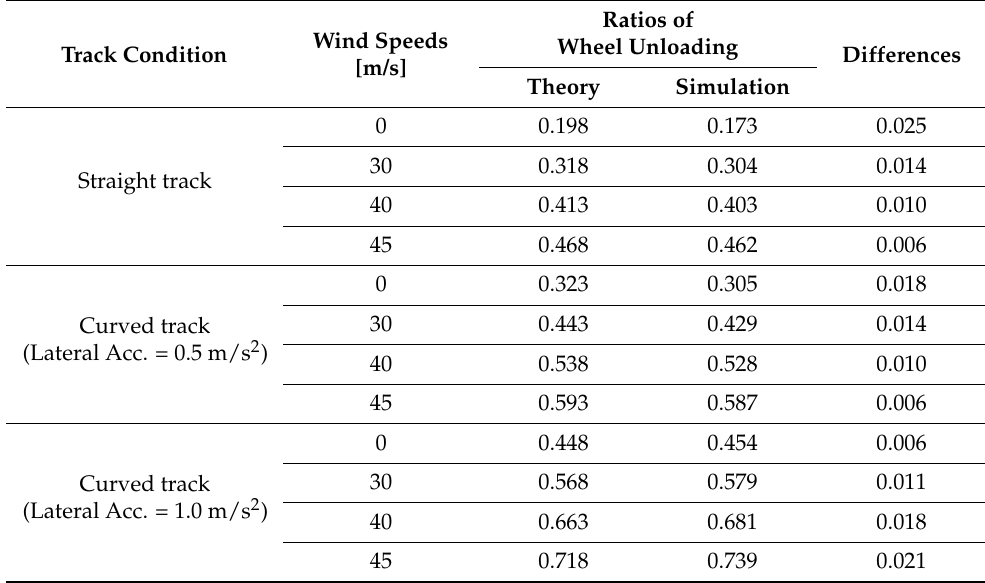
Curved track (Lateral Acc. = 1.0 m/s 2 )